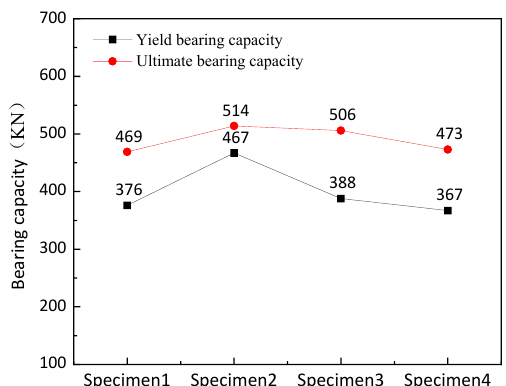
Figure 11. Comparison of bearing capacity of specimens.